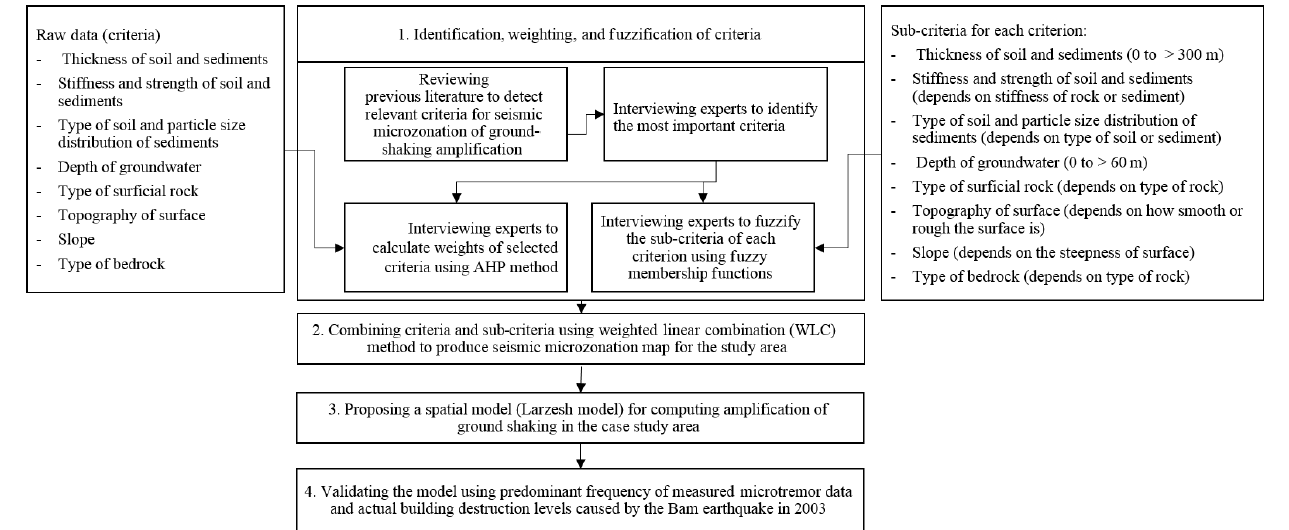
Figure 2. The methodological approach of the